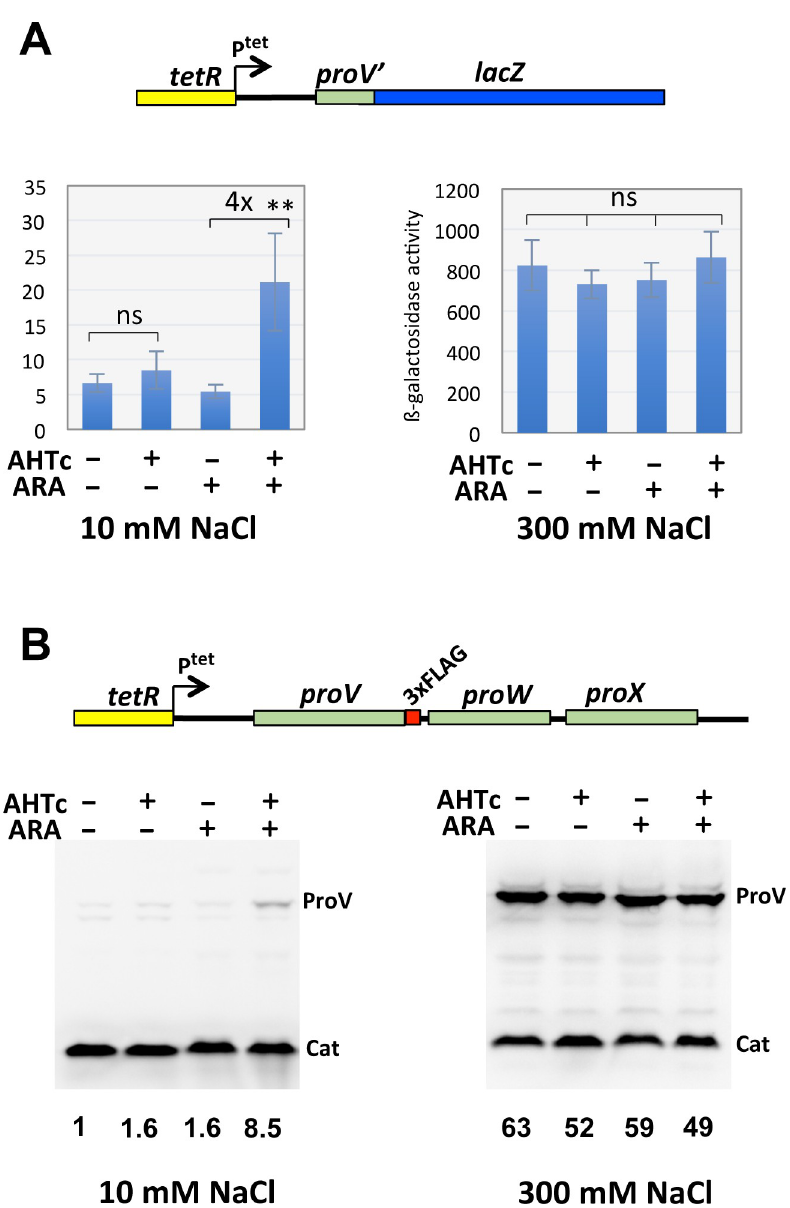
Fig 5. Partial relief of proU repression by invading transcription. The tetR -P tet cassette was inserted 352 bp upstream from the beginning of the proV orf and the resulting construct moved into strains carrying either al transcriptional lacZ fusion placed 289 bp downstream from the beginning of the proV orf (A) or a C-terminal 3xFLAG fusion to proV (B). The effects of transcription from P tet ( ± AHTc) are analyzed in the presence or absence of NusG (- ARA and + ARA, respectively) on early stationary cultures grown in LB medium supplemented with either 10 mM NaCl or 300 mM NaCl (high osmolarity). (A) Quantification of proV-lacZ expression. Cultures were processed for the determination of ß-galactosidase activity as described in Materials and methods. The assays were repeated twice, each time using two independent cultures. Statistical significance was calculated by the Student’s T test (two-tailed, unpaired; �� , P < 0.01). (B) Western blot detection and quantification of ProV-3xFLAG. Values below the blots represent the fold change in band intensity relative to the untreated low osmolarity sample (leftmost lane of left blot), normalized to the Cat band for each lane. Band intensity was quantified with